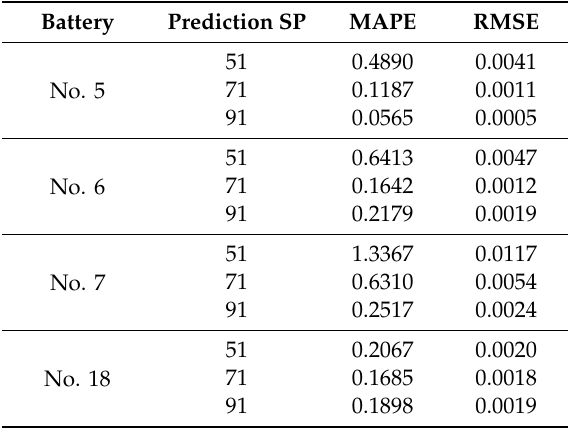
Table 3. Prediction performance at di ff erent prediction SP of each battery.